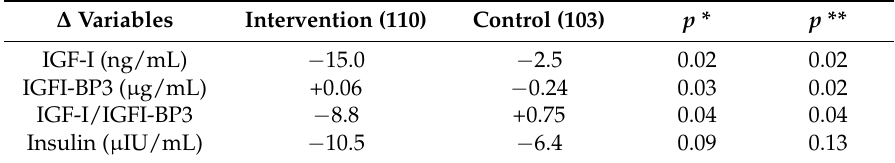
Table 4. Intention-to-treat analysis for ∆ IGF-I, ∆ IGFI-BP3, ∆ IGF-I/IGFI-BP3 and ∆ insulin. ∆ Variables Intervention (110)